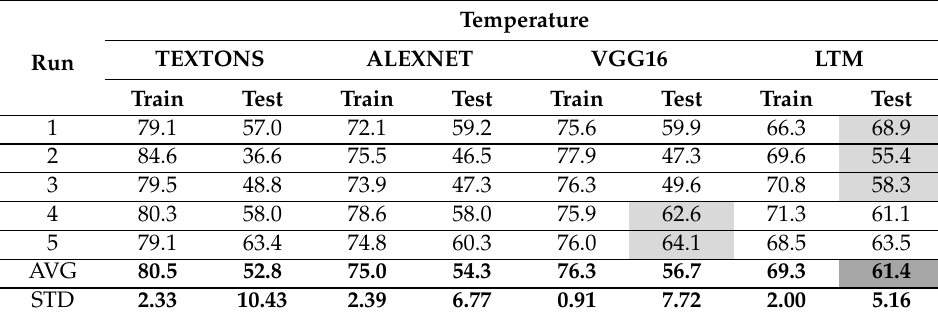
Table 4. Results of classification (% correct) with predictor sets derived from the mill temperature data and use of a cubic kernel support vector machine.